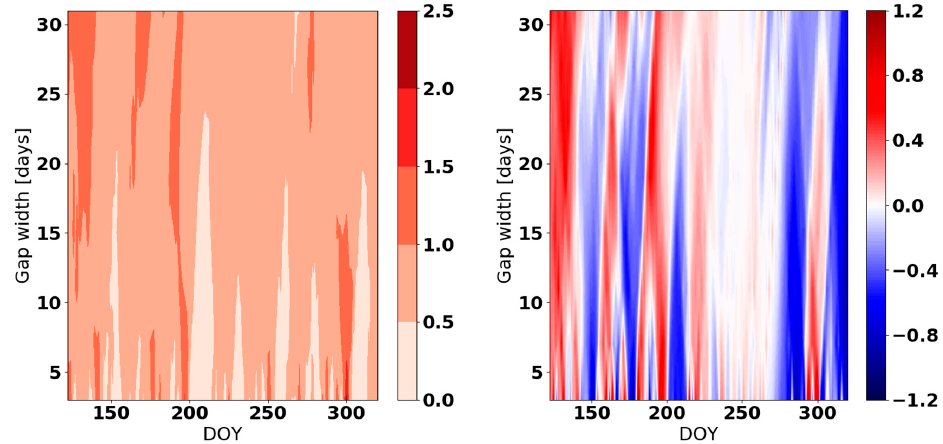
Figure A9. RMSE DEB ( left panel ) and (RMSE DEB -RMSE ERA5 ) difference ( right panel ) calculated using daily data for DOY 122-320 2016 in Montecristo.